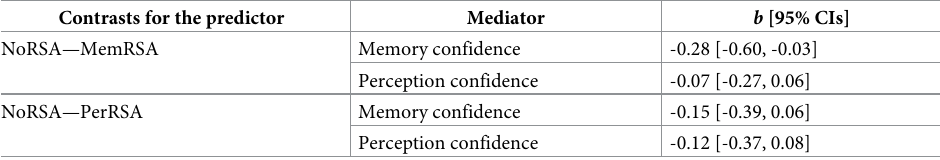
Table 2. Results of mediation analysis—Experiment